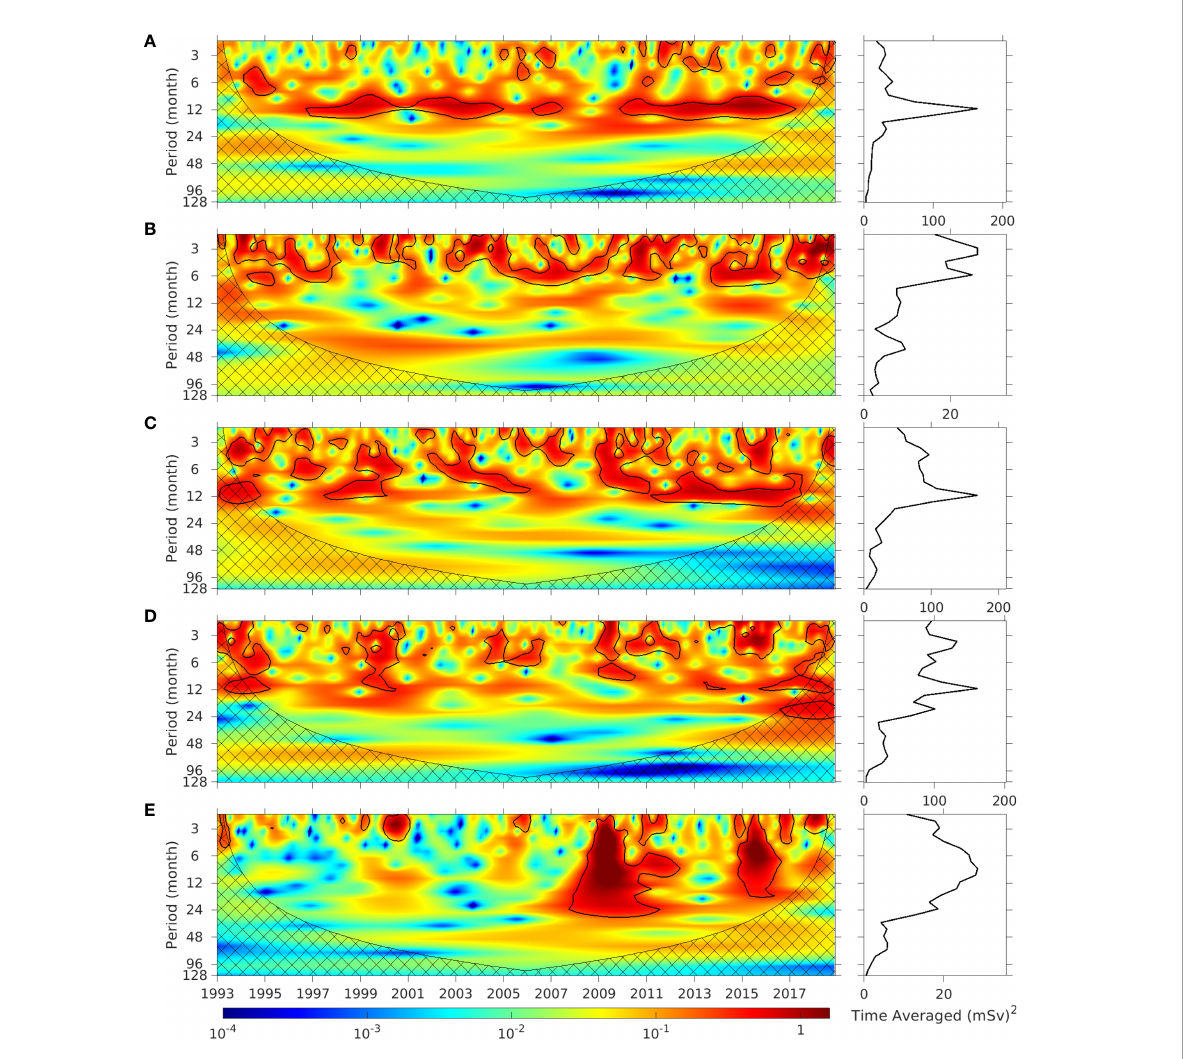
FIGURE 8 Left: normalized recti fi ed wavelet power spectra for the time series through sections (A – E) shown in Figure 7. Values within the black contours are above the 90% con fi dence level. Values overlaid with crossed lines are affected by the edge effects. Right: the time-averaged wavelet power spectra multiplied by the variance of the FWT time